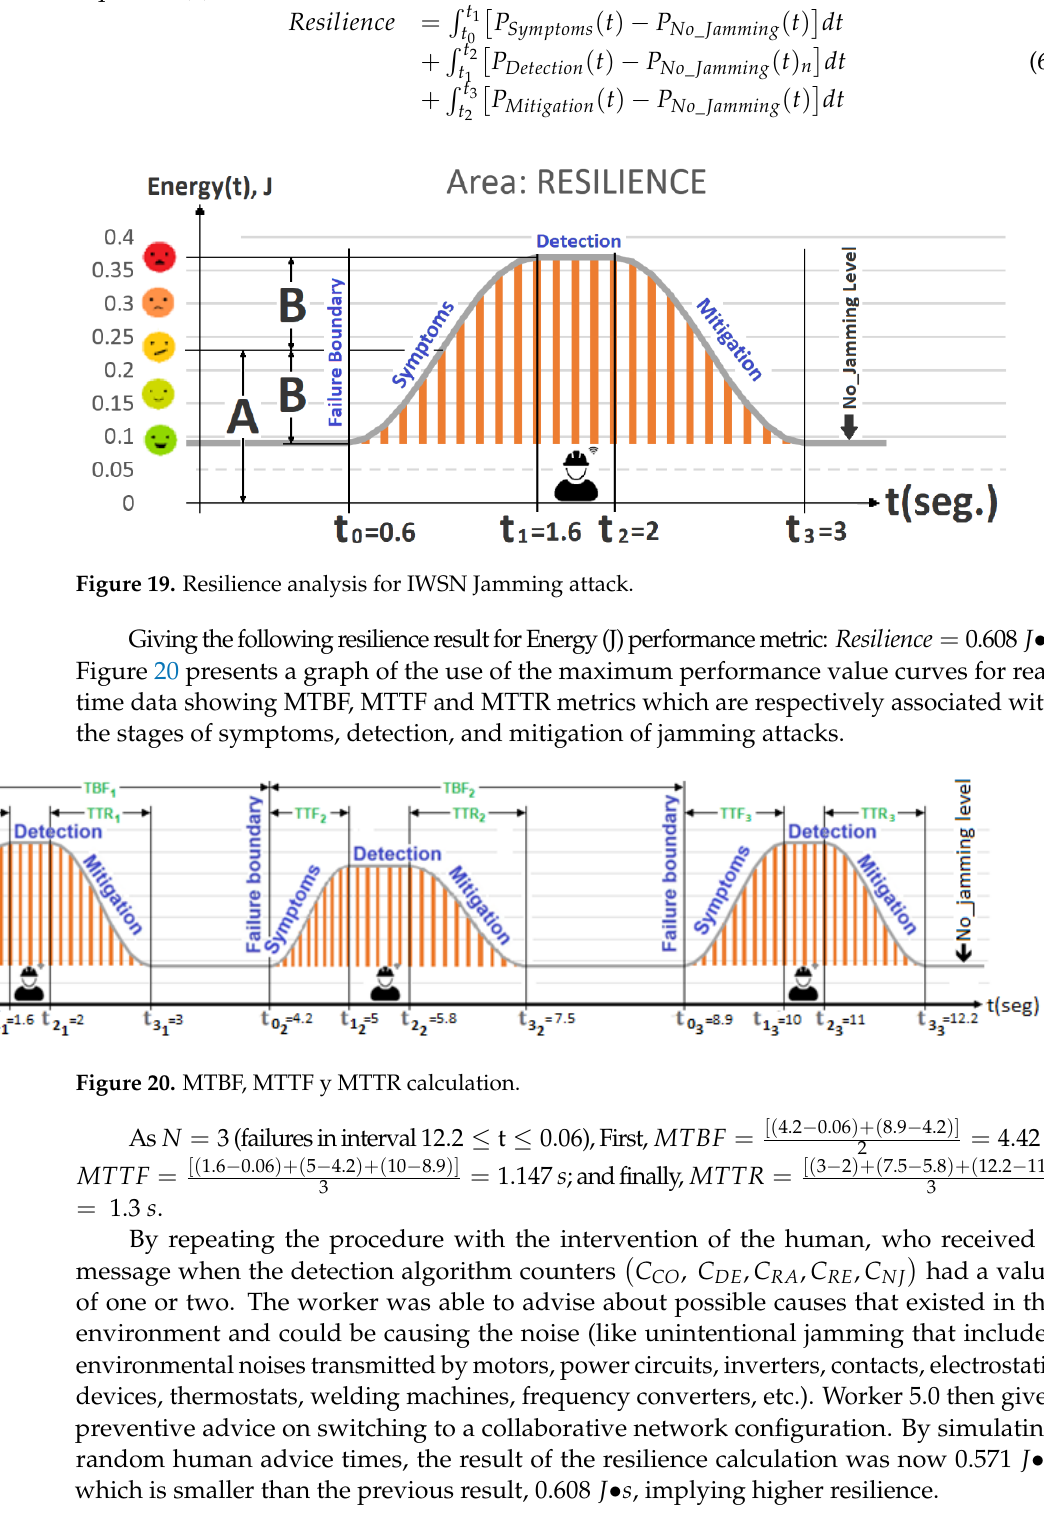
Figure 19. Resilience analysis for IWSN Jamming attack.